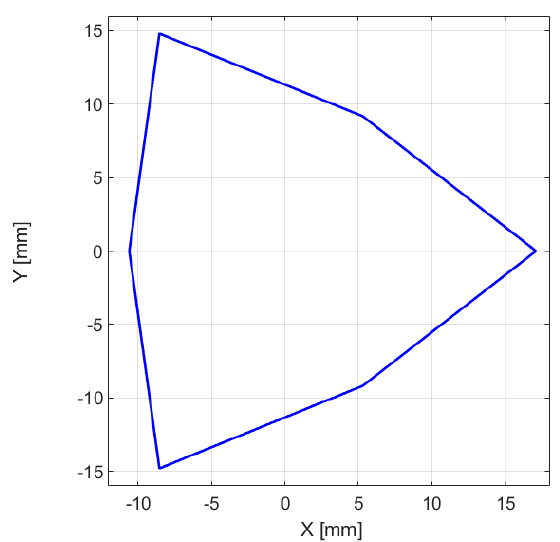
Figure 8. XY projection of the workspace.